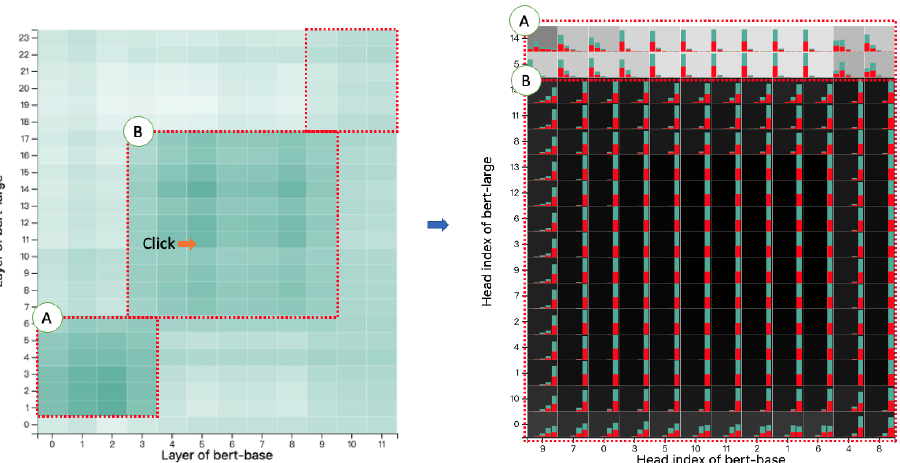
Figure 22. The user explores the layer similarity group to find a layer combination (orange arrow) in the corresponding head similarity graph with two clear